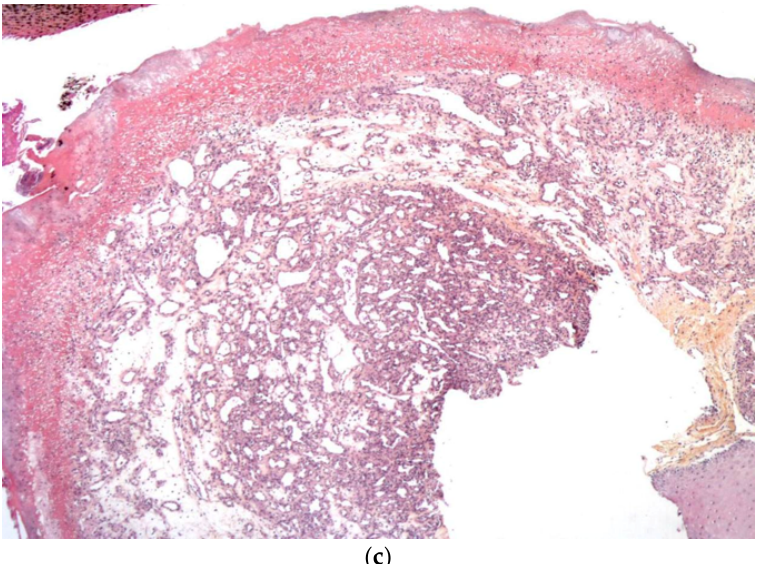
Figure 14. Neonatal pyogenic granulomas. ( a ) Small red typical pyogenic granuloma. ( b ) 4× lobulated vascular lesion in the dermis. The overlying epidermis is normal whereas in ( c ), it is ulcerated and the lesion contains inflammatory cells.